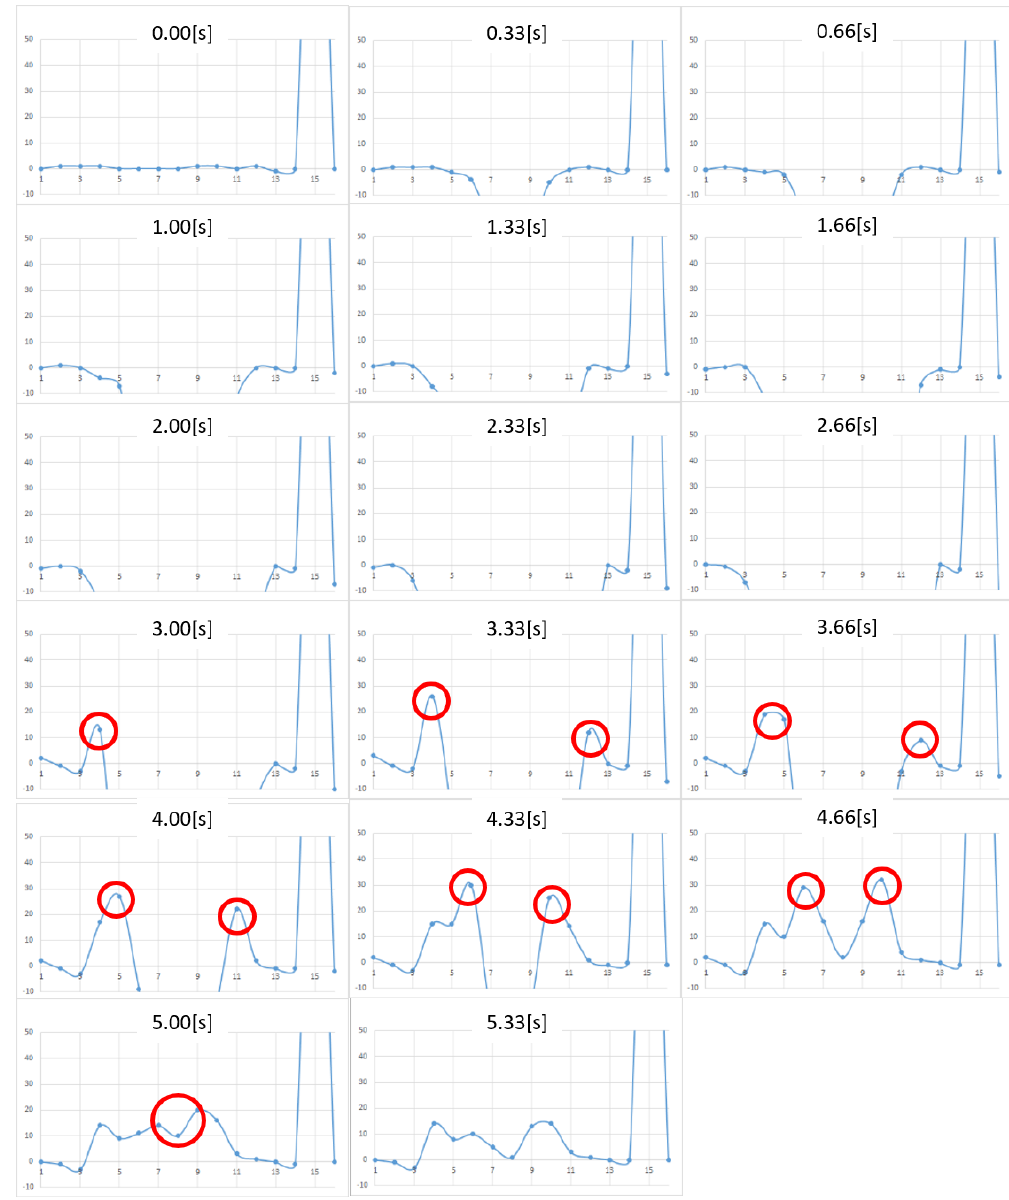
Figure 13. Change in pressure distribution for toothpaste. The vertical axis represents the force (in milli newton). The horizontal plane represents the location of the sensing point.